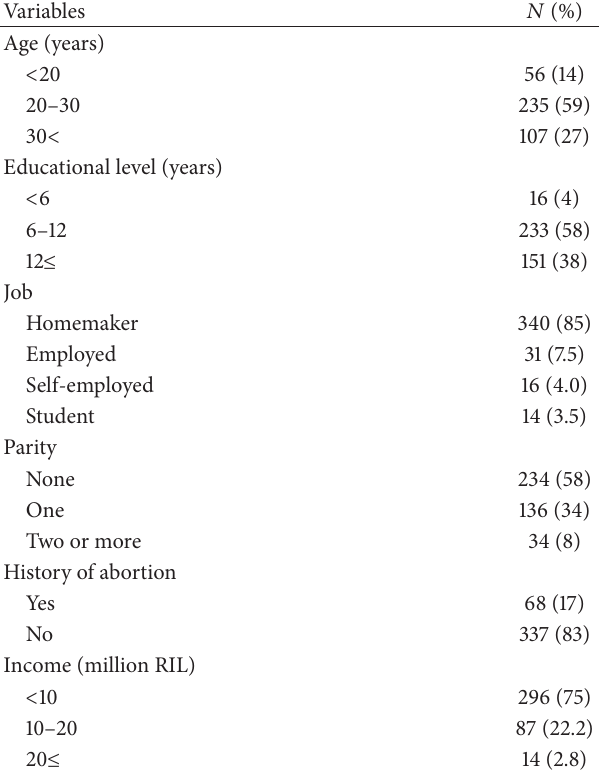
Table 1: Women’s